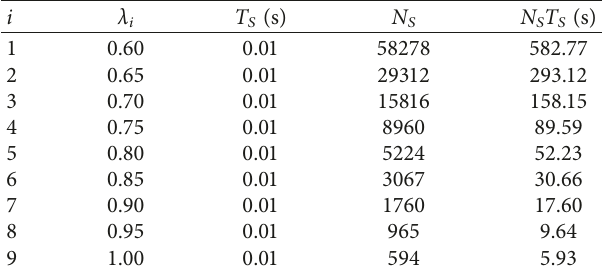
Table 11: Set of process fractional orders, sampling periods, number of samples, and time length used in FFOPDT step re- sponses for processes P 1,i ( i � 1, ... , 9).